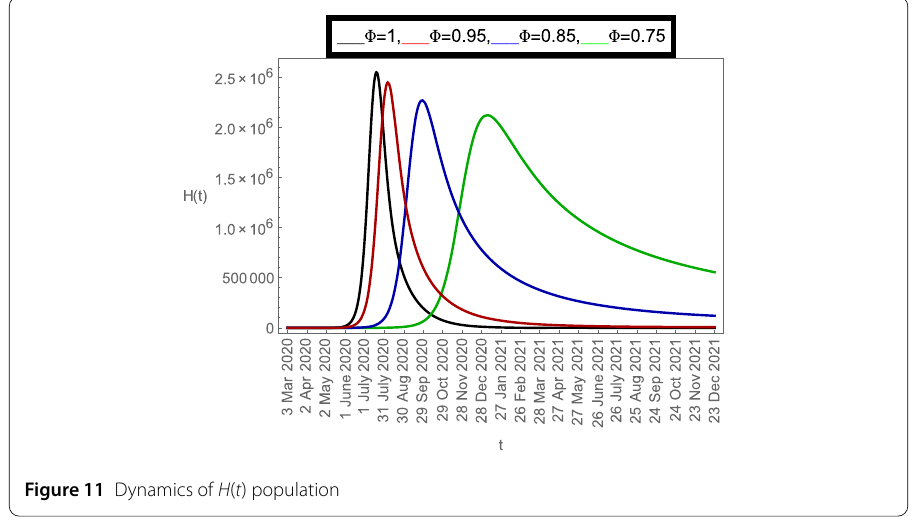
Figure 11 Dynamics of H ( t ) population